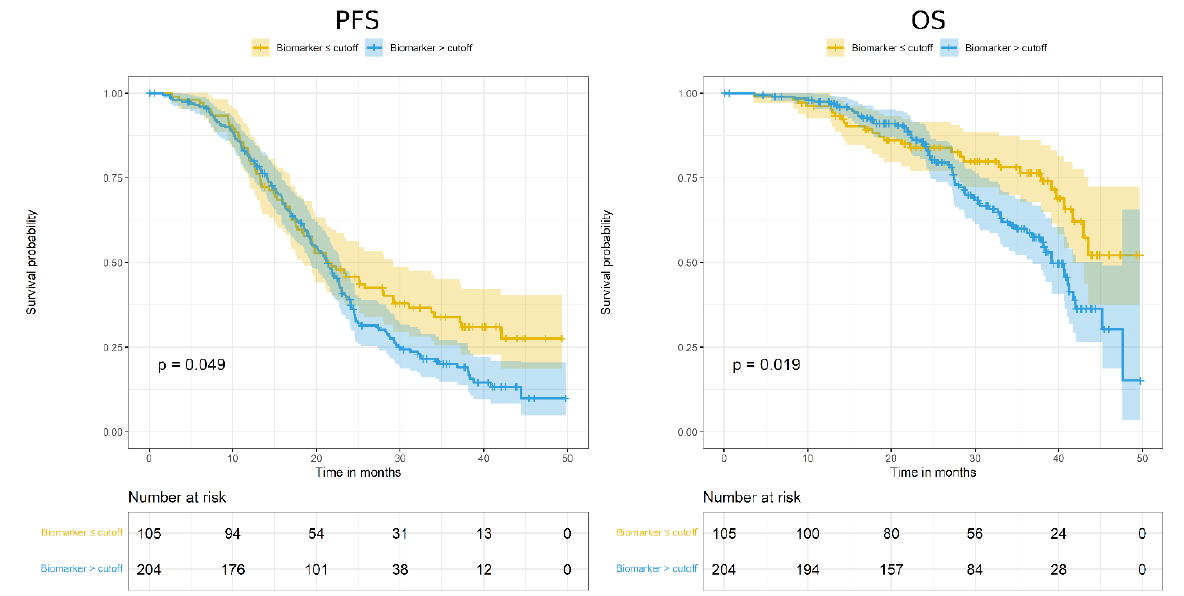
Figure 2. Kaplan–Meier curves assessing progression-free survival (PFS; left ) and overall survival (OS; right ) according to ADAM17 expression, as dichotomized around the cut-off value of H score = 50. Table 3. Univariate and multivariate analysis for ADAM17 (categorized on best cut-off value) for PFS and OS. Original and shrunken coefficients are